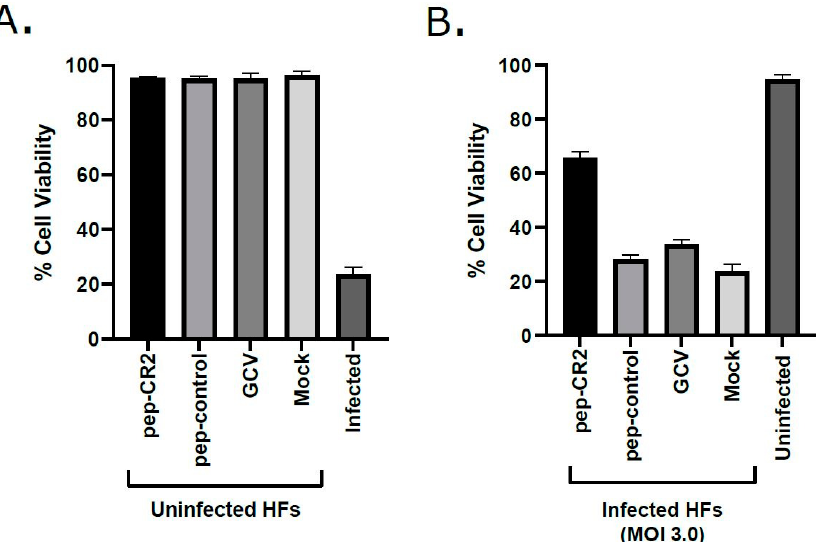
Figure 5. Cell viability (%) in ( A ) pep-CR2-treated uninfected cells vs. ( B ) pep-CR2-treated infected cells. Cells were pretreated with pep-CR2 as well as with appropriate controls (pep-control and GCV) or mock (in triplicates) for 1 h and were then either infected with HCMV at a high MOI of 3.0 or mock-infected. Cell viability was performed by trypan blue exclusion assay at 5 dpi for both groups. Results indicate that pep-CR2 protects cells from virus-induced lytic cell death. Samples were analyzed with one-way ANOVA in GraphPad Prism 9.0 and showed significant differences between groups ( p < 0.05).